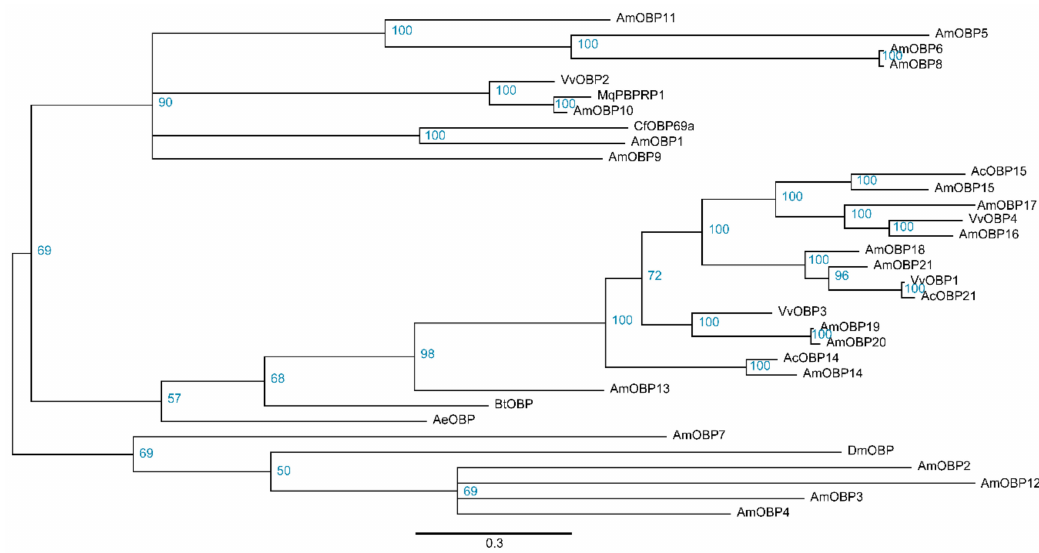
Figure 7. Phylogenetic analysis of insect odorant binding proteins (OBPs) in the brain of Vespa velutina and other seven insects. Vv, Vespa velutina ; Am, Apis mellifera ; Ac, Apis cerana ; Mq, Melipona quadrifasciata ; Bt, Bombus terrestris ; Ae, Acromyrmex echinatior ; Cf, Camponotus floridanus ; Dm, Drosophila melanogaster